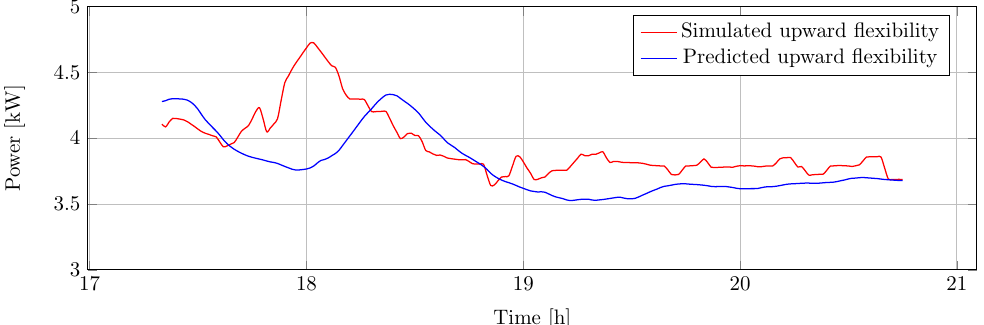
Figure 15. Sample from the upward flexibility prediction between 17:20 and